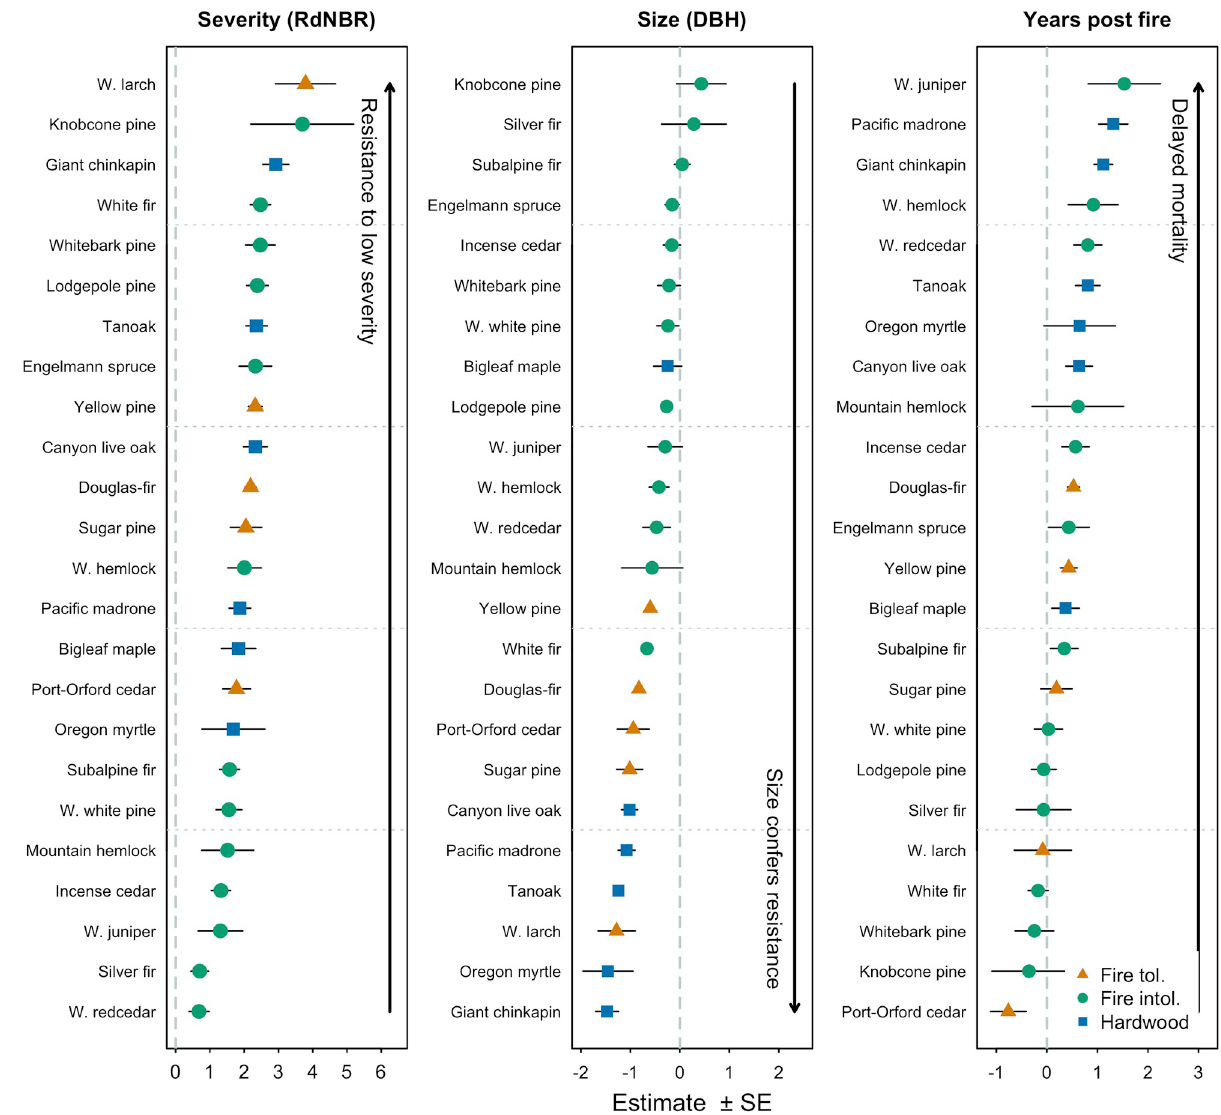
Fig 2. Standardized Generalized Linear Mixed Model coefficient estimates ( ± SE) for the effect size of fire severity, tree diameter at breast height, and number of years after the fire post-fire plot sampling occurred (Years Post Fire) on the probability of tree mortality for the 24 most common tree species from 304 forest inventory plots in Oregon and Washington that burned between initial measurements in 1992–1997 and remeasurements in 1997–2007. Standardized coefficients allow comparison between species models and predictors. For species in which the final selected model included a severity × size interaction term, plotted coefficients represent the effect of severity when size is held constant at its mean and vice versa. See Table 3 in S1 Appendix for unstandardized estimates and statistical results.